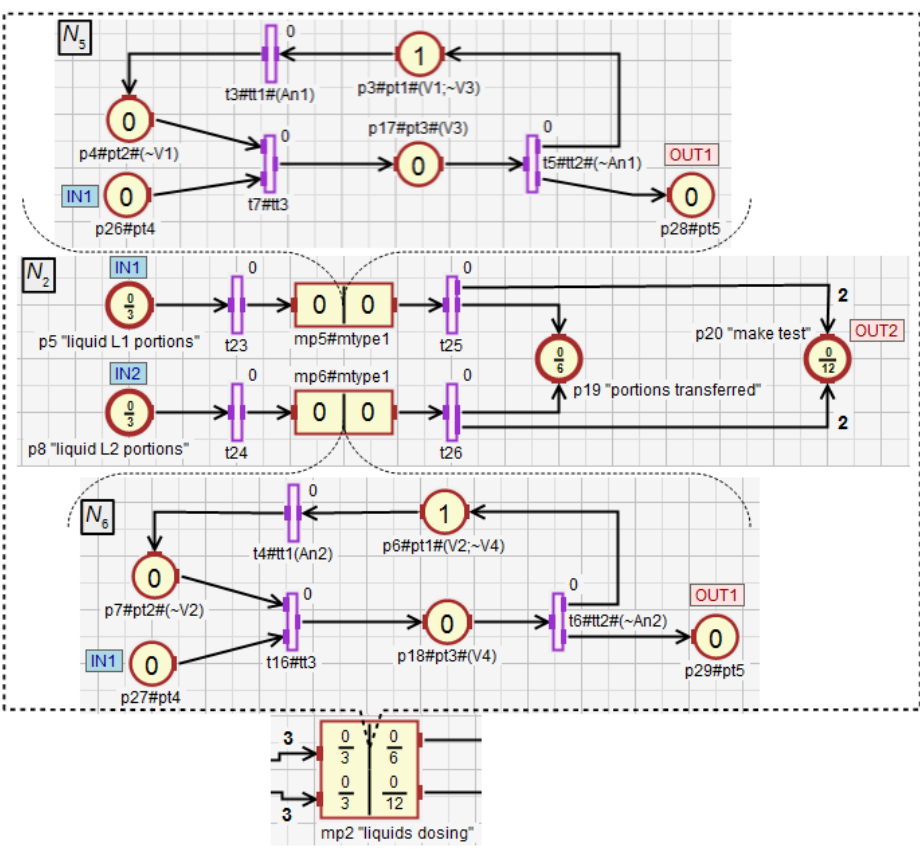
Figure 14. Dosing module for the liquids L 1 and L 2